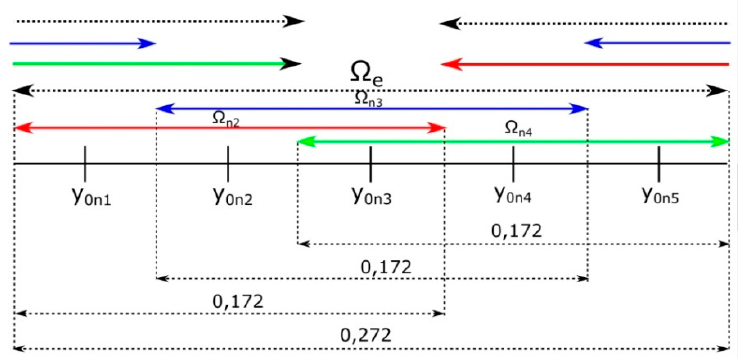
Figure 12. Illustration of the relationship between supports Ω e and Ω n